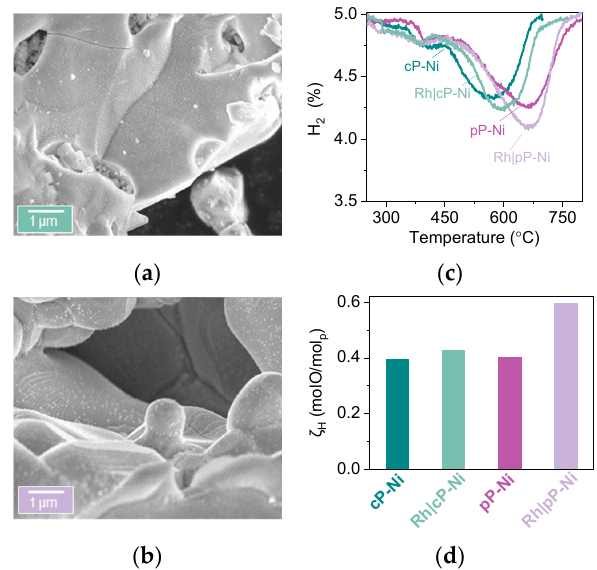
Figure 6. Infiltrating exsolved samples with Rh. Microstructure (SEM) analysis of the impregnated ( a ) coarse powder (Rh | cP-Ni) and ( b ) pellet (Rh | pP-Ni) after reduction (HTPR experiments). ( c ) Temperature programmed reduction (HTPR) and ( d ) ( ζ H) calculated oxygen capacity from experiment described in ( d ).